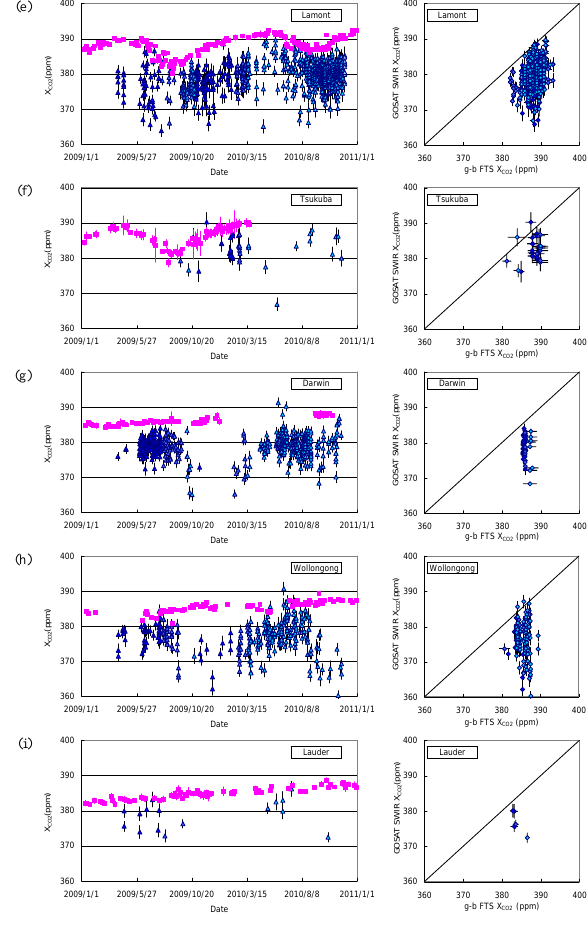
Fig. B2. Scatter diagram between GOSAT and g-b FTS X CO all FTS sites. The GOSAT data were retrieved within ± 5 degrees latitude/longitude box centered at each g-b FTS site and the g-b FTS data were the mean values measured within ± 1 h of GOSAT overpass